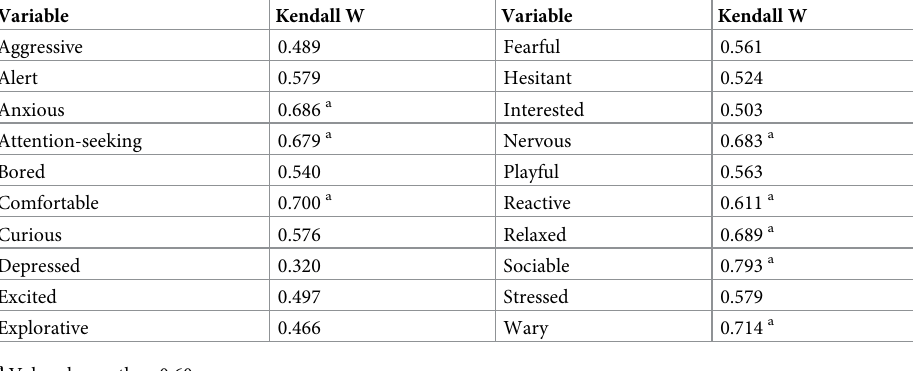
Table 7. Kendall’s W coefficients of concordance (n = 11) for the 20 QBA terms.